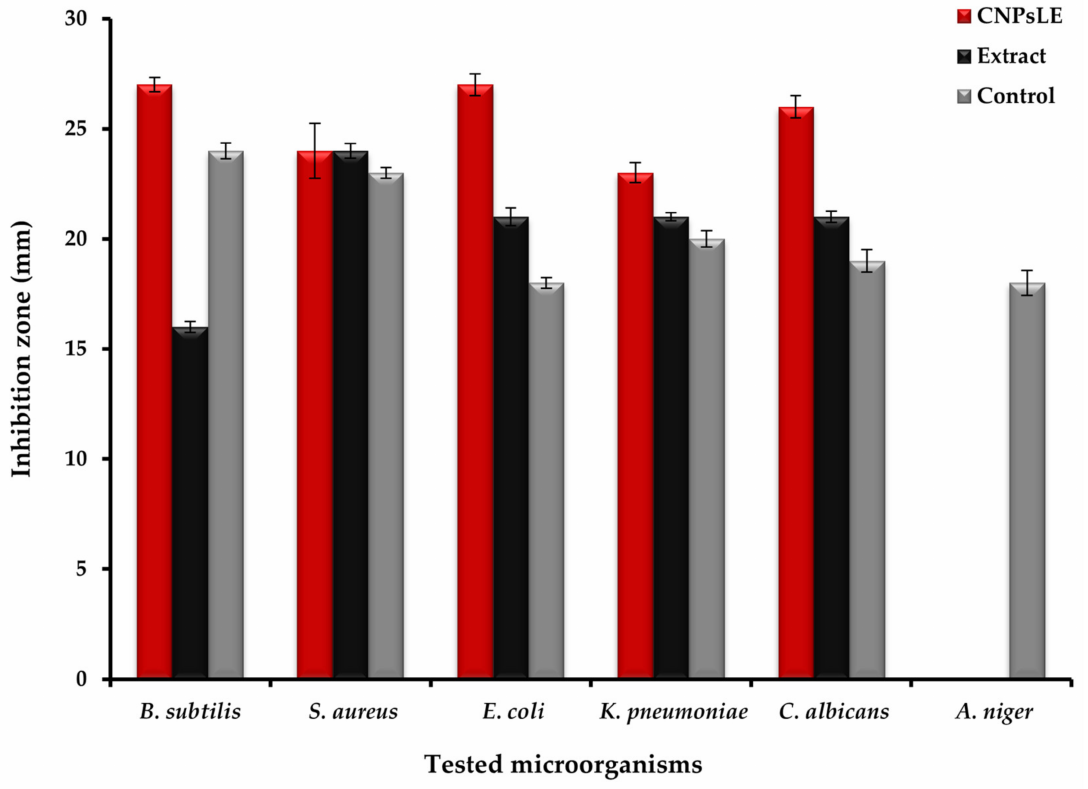
Figure 4. Antimicrobial activity of Artemisia judaica extract, chitosan nanoparticles loaded extract (CNPsLE), and chitosan towards multiple pathogenic bacterial and fungal